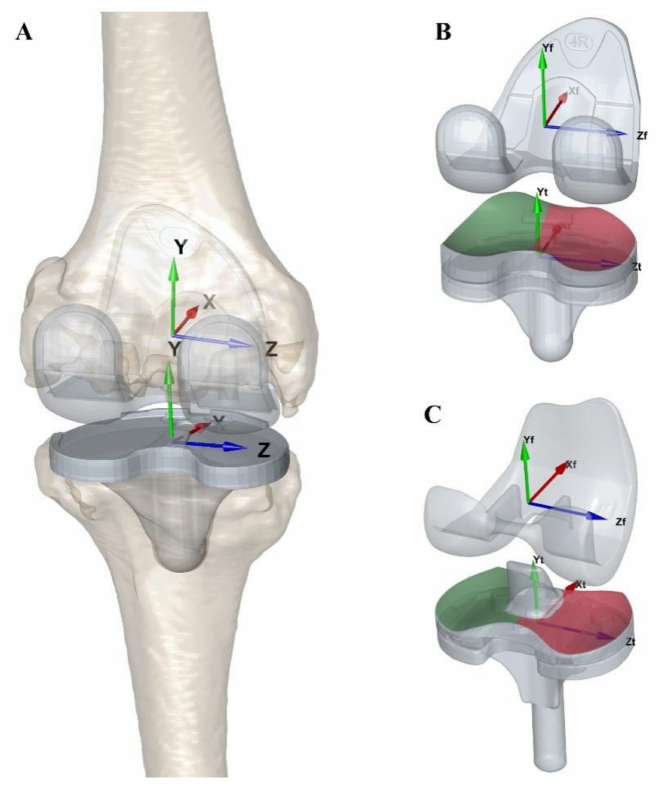
Figure 1. ( A ) The Anatomical coordinate system definition of right TKA patients. The origin of the femur was defined as the midpoint of the clinical transepicondylar axis (c-TEA). The origin of the tibia was defined as the center of the tibial plateau. ( B ) The local coordinate systems of MP-TKA components. ( C ) The local coordinate systems of PS-TKA components. The red (X-axis), green (Y-axis) and blue (Z-axis) arrows indicated the anterior/posterior (AP), proximal/distal (PD) and medial/lateral (ML) axes, respectively. The tibial polyethylene (PE) insert was divided into medial up-surface (green area) and lateral up-surface (red area) according to the local sagittal plane. MP: Medial-pivot. PS: Posterior-stabilized. TKA: Total knee